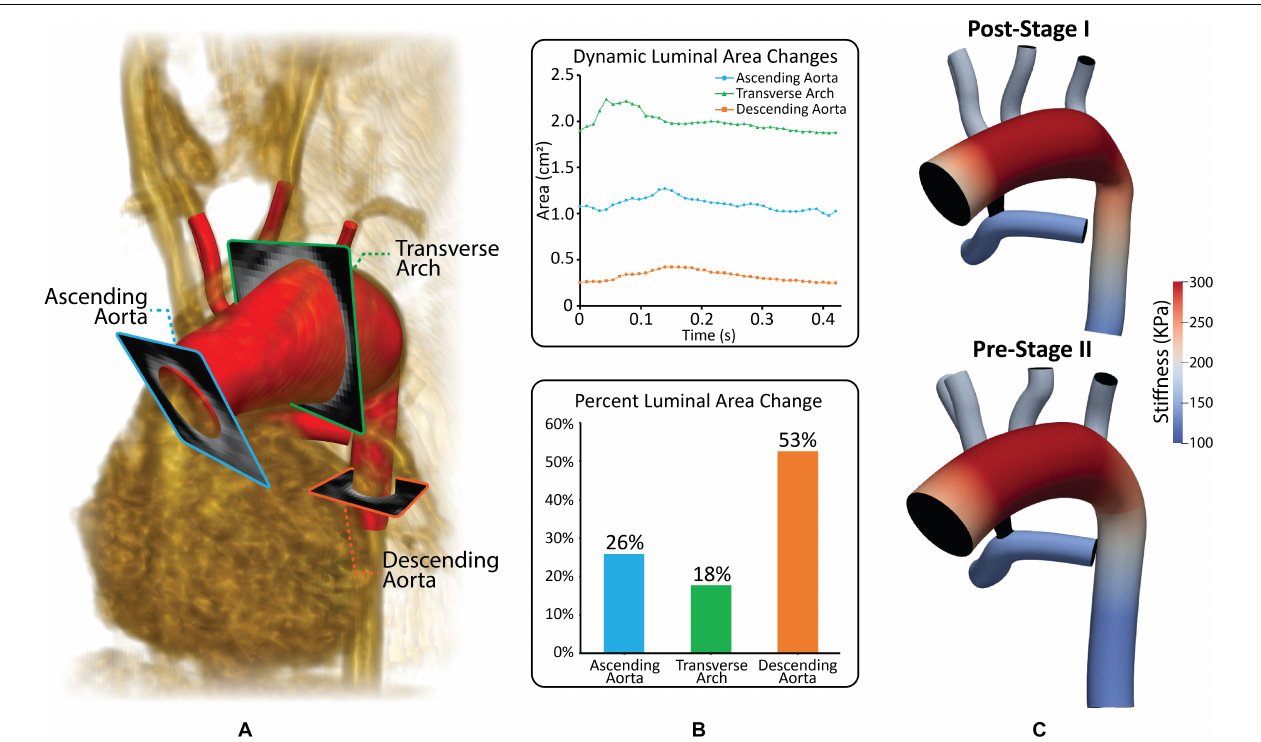
FIGURE 4 | (A) Reconstructed geometry with volume-rendering of MRA data and three different PC-MRI planes. (B) Plot of dynamic luminal area changes and percent luminal area changes at the ascending aorta, transverse arch and descending aorta PC-MRI planes. (C) Material properties applied to both the post-S1 and pre-S2 models. Stiffness values were calculated based on patient-specific pressure measurements and dynamic luminal area changes measured from MRI data (Hirai et al.,